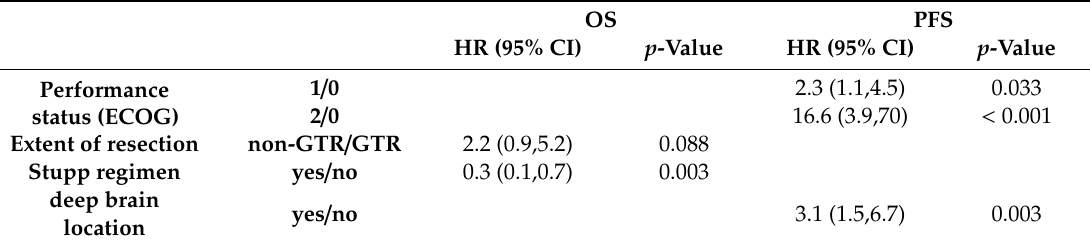
Table 4. Multivariable analysis in patients with